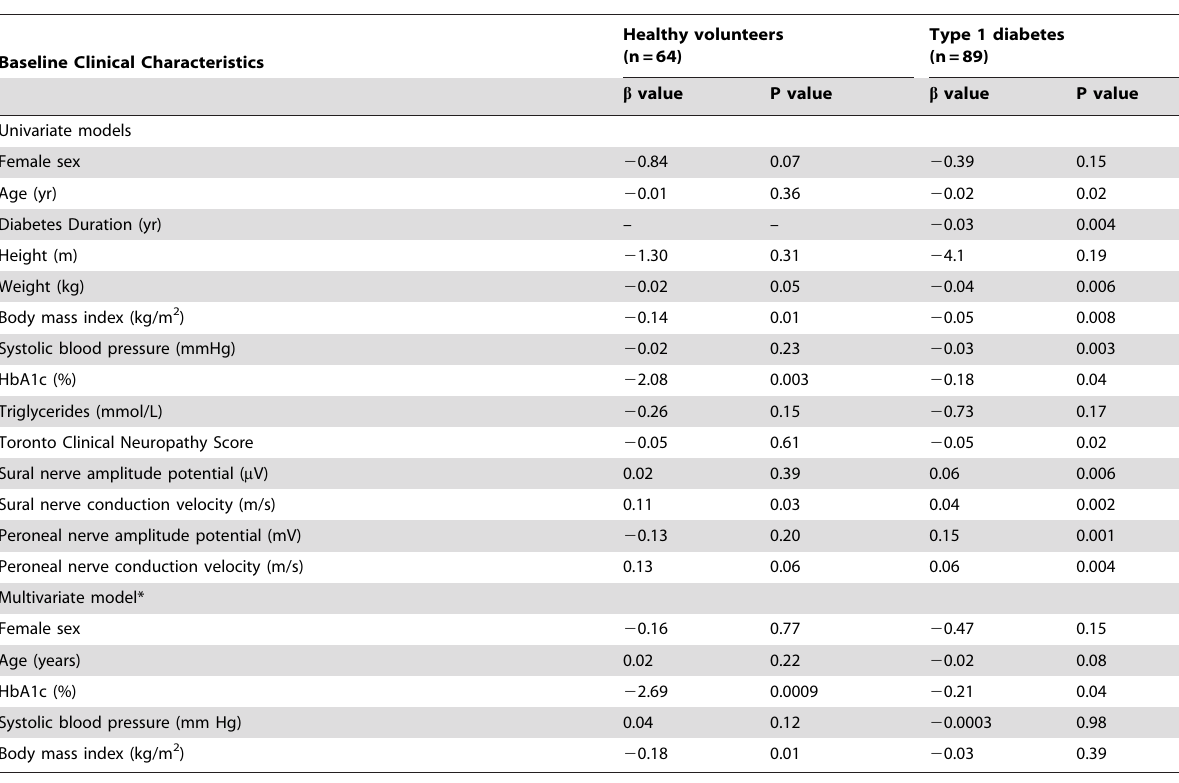
Table 2. Regression Analysis Of LDI FLARE Area And Baseline Demographics.